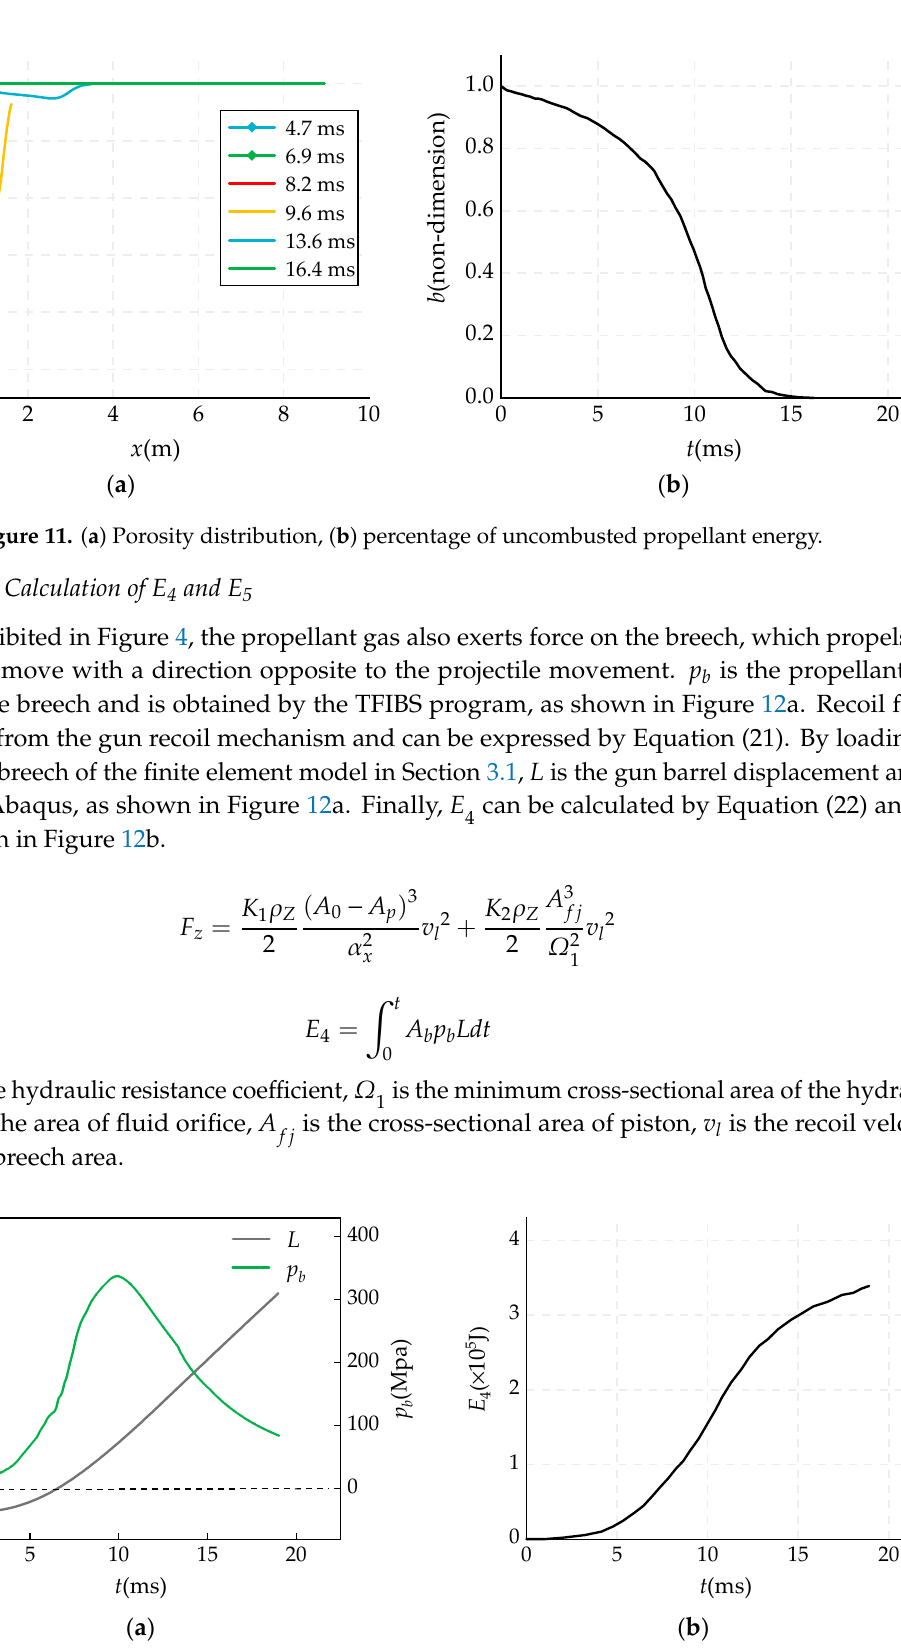
Figure 12. ( a ) Pressure at breech and gun barrel displacement, and ( b ) recoil energy.